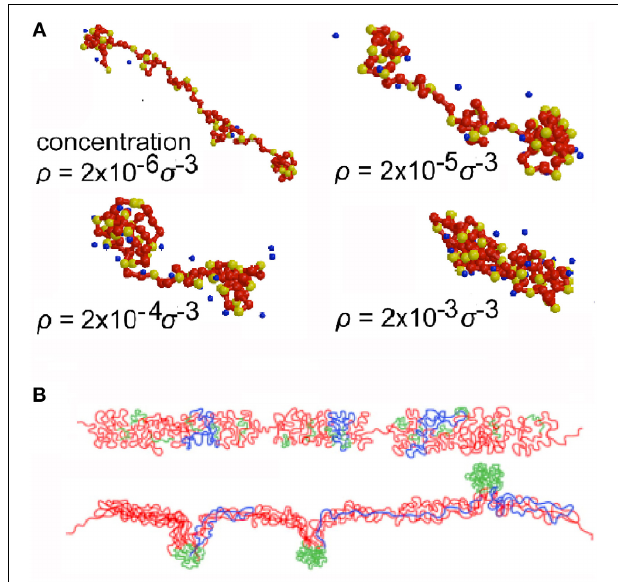
FIGURE 3 | Conformations of chromatin fibers. (A) Simulation by Molecular Dynamics of a linear polyelectrolyte polymer resembling chromatin at increasing concentration ( ρ ) (self-crowding) (reproduced from [34] with permission of ACS Publications, © 1999). (B) Conformations in vivo of the DNA of a transgene deduced from studies using FISH; the transgene DNA is red, bacterial artificial chromosome DNA is blue, and lac operator DNA is green (reproduced from [32] by permission of Rockefeller University Press, © 2010).